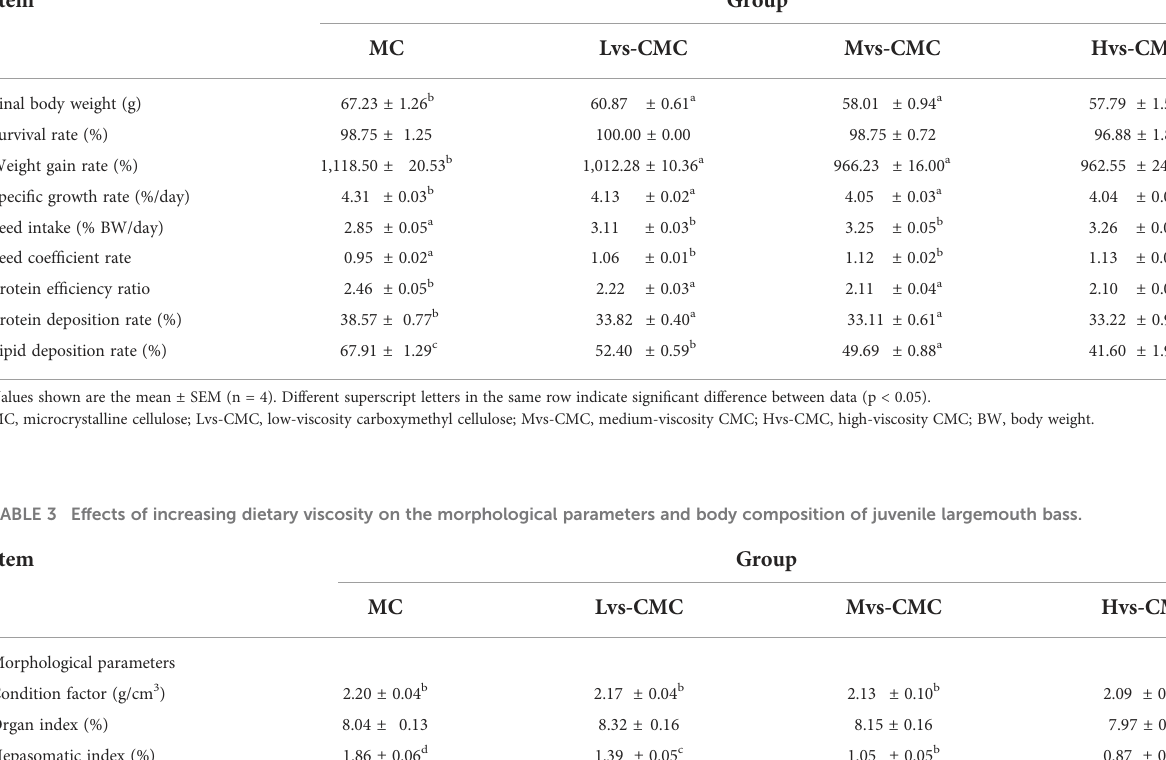
TABLE 2 Effects of increasing dietary viscosity on the growth and feed utilization of juvenile largemouth